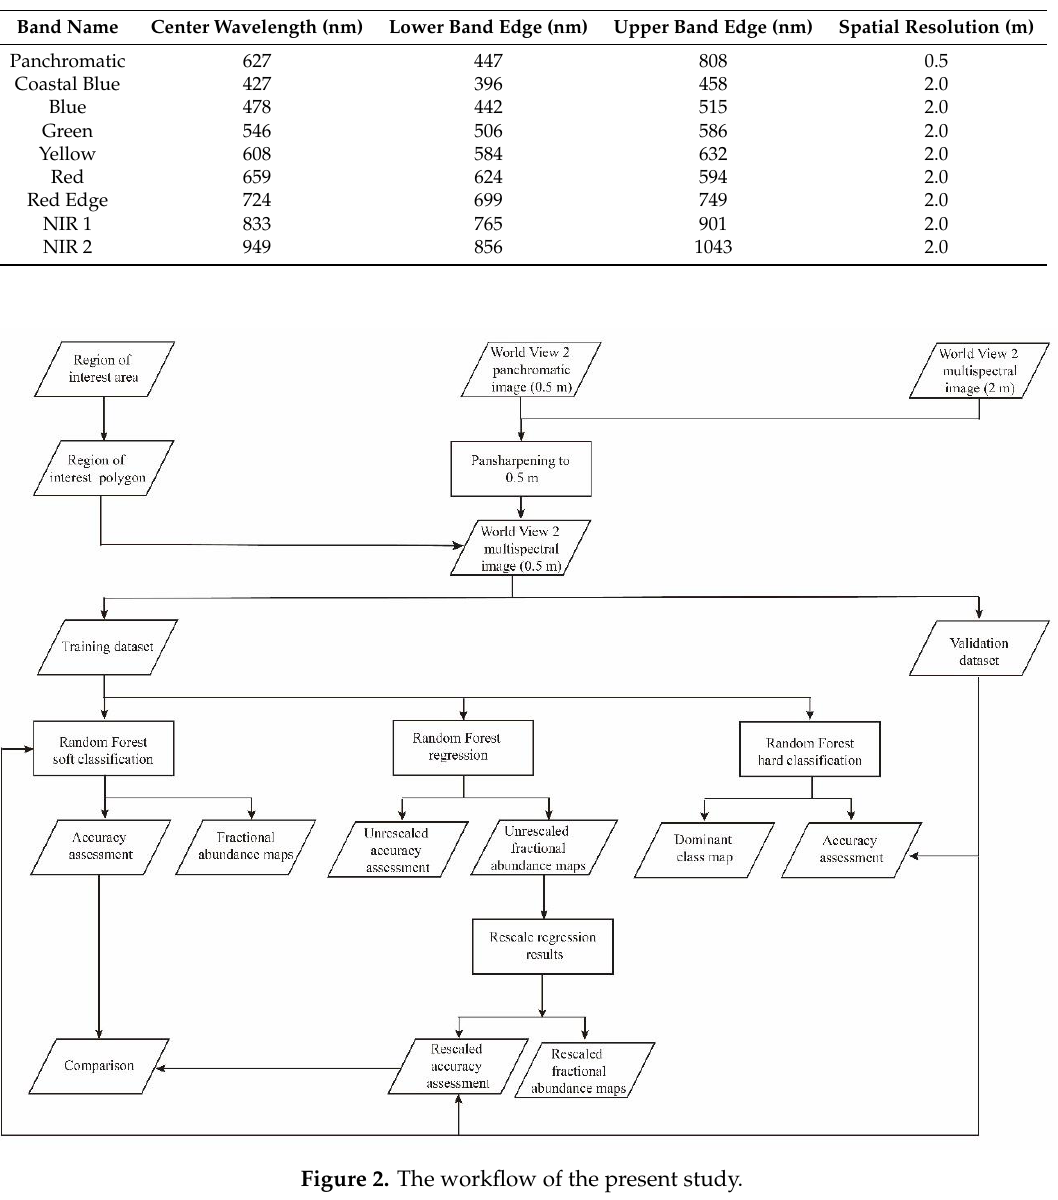
Table 1. WorldView-2 spectral band edges and center wavelengths. NIR 1 = near-infrared 1; NIR 2 = near-infrared 2.